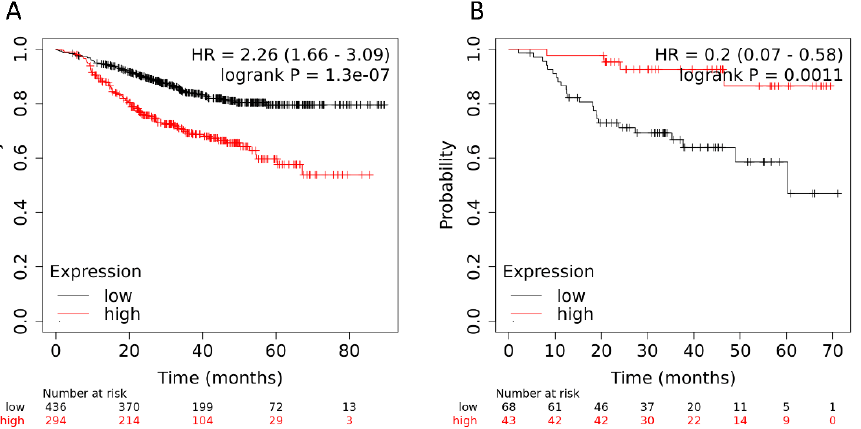
Figure 5. Metastatic-free survival of patients with breast cancer depending on the signature of gene